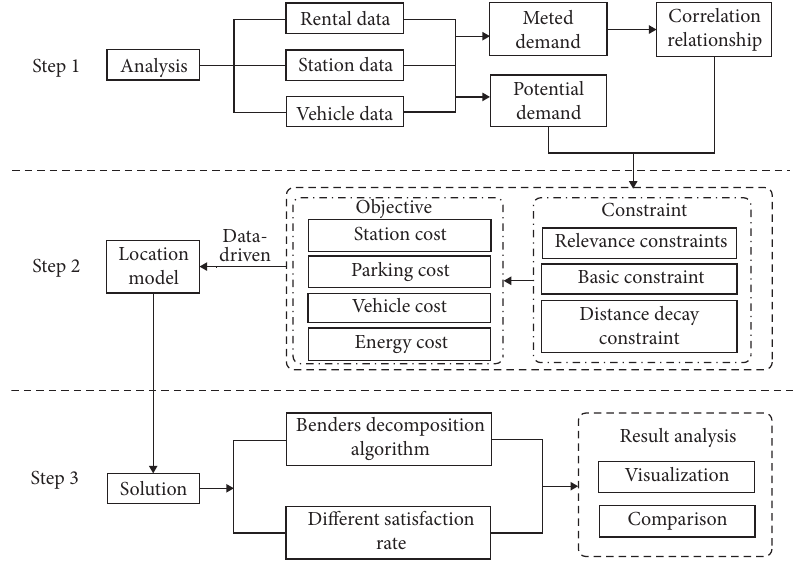
Figure 1: Methodology